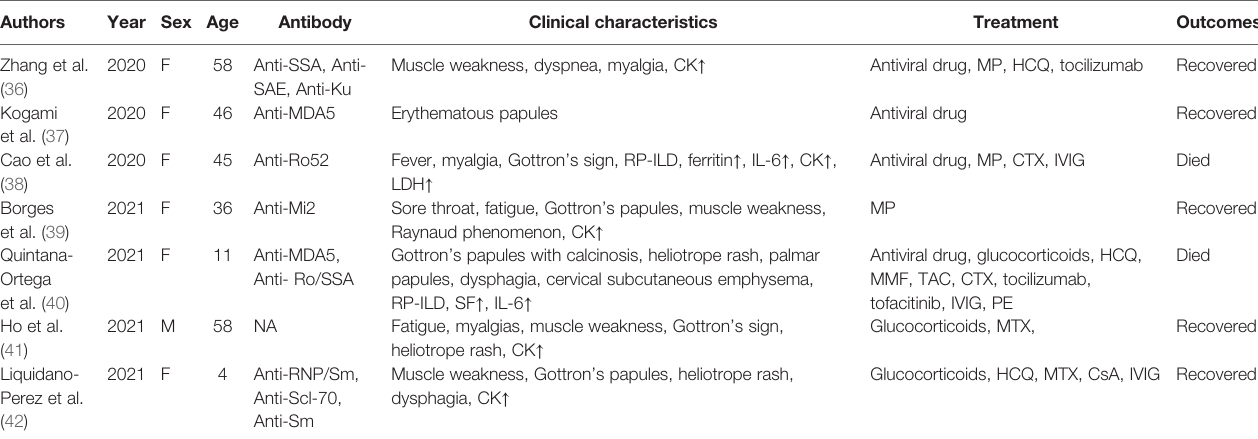
TABLE 1 | Cases of COVID-19-associated